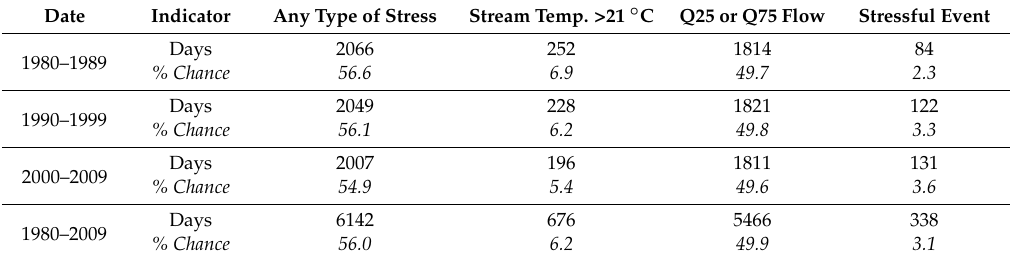
Table 5. Stressful event analysis of SWAT with the hydroclimatological component. Shown is the percent chance that of the 3653 days per each decade and 10,958 days between 1980 and 2009, a day with any type of stress will occur, a day with flow stress will occur, a day with temperature stress will occur and the percent chance of an event.